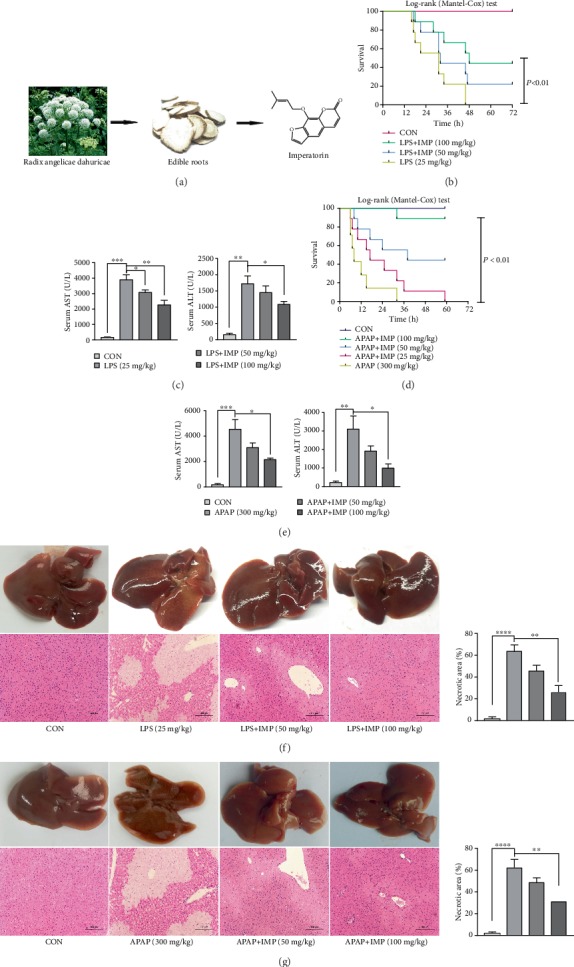
Pretreatment with IMP protects against APAP overdose-induced acute liver injury and necrotic death. IMP (50 or 100 mg/kg) was intragastrically administrated to mice for 5 days, which then received LPS (25 mg/kg) or APAP (300 mg/kg) by intraperitoneal injection after fasting overnight. Mice were sacrificed after 10 h; serum and liver samples were collected for further analysis. (a) The source of the IMP as a bioactive natural product. (b) The survival rate of mice (with/without IMP pretreatment) after intraperitoneal injection of LPS for 72 h. (c, e) Serum was harvested for measurement of serum ALT and AST levels. (d) The survival rate of mice (with/without IMP pretreatment) after intraperitoneal injection of APAP for 72 h. (f) Changes in the appearance of solid liver tissue and representative images of H&E staining of liver sections (with/without IMP pretreatment) with LPS injection (magnification: 200x). (g) Changes in the appearance of solid liver tissue and representative images of H&E staining in mouse liver sections (with/without IMP pretreatment) with APAP injection (magnification: 200x). ∗p < 0.05; ∗∗p < 0.01 versus vehicle-treated control group. IMP: imperatorin; ALT: alanine aminotransferase; AST: aspartate transaminase.